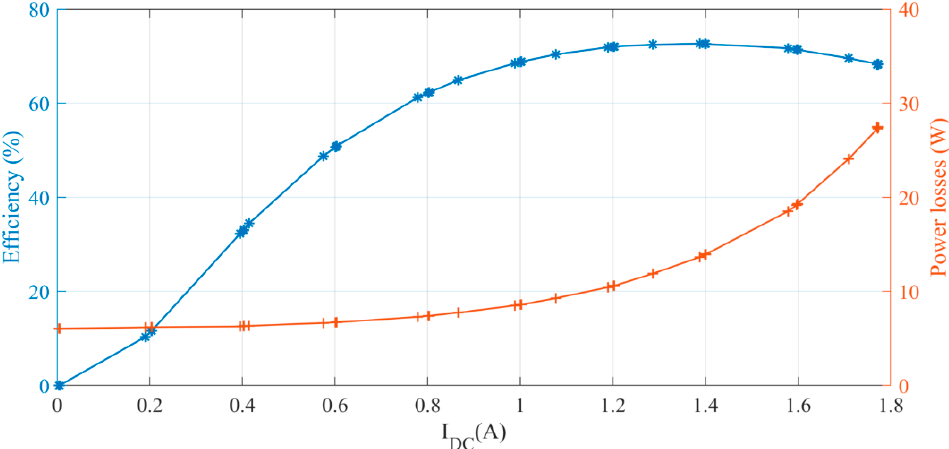
Figure 13. Basic waveforms for serial resonant operation ( I DC = 1 A): measurements; ( a ) simulation results; ( b ) top waveforms: Output voltage from inverter, bottom: Current from inverter.